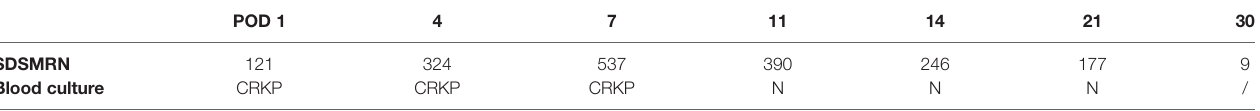
TABLE 6 | Dynamic changes in standardized unique read of CRKP by